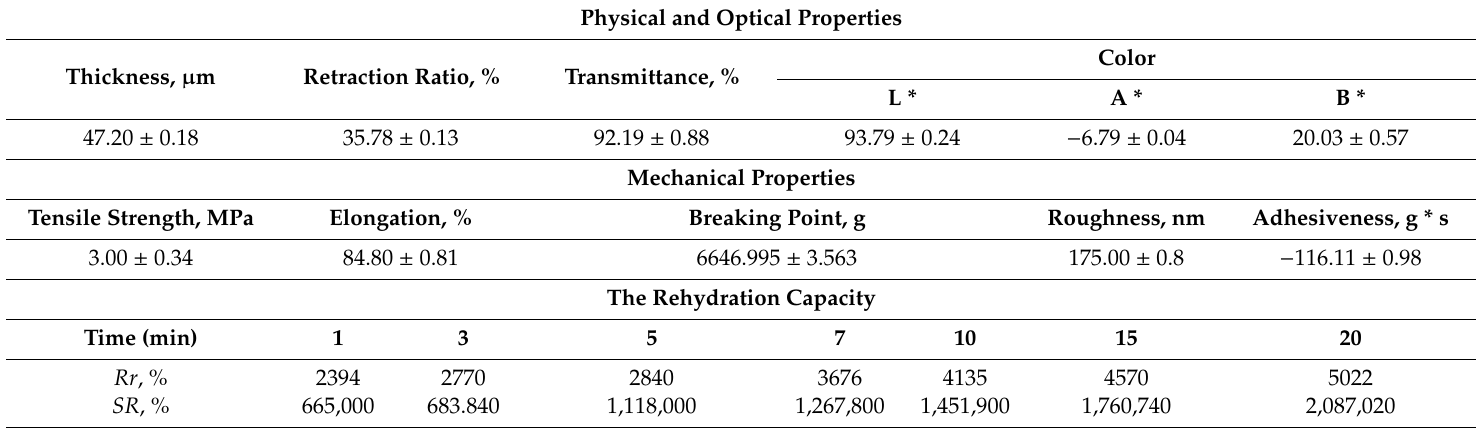
Table 1. Characteristics of the new material